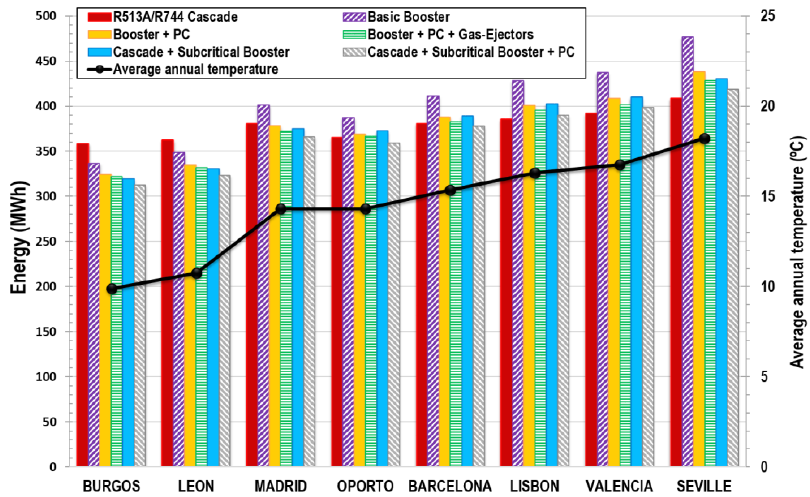
Figure 17. Annual energy consumption in different cities.